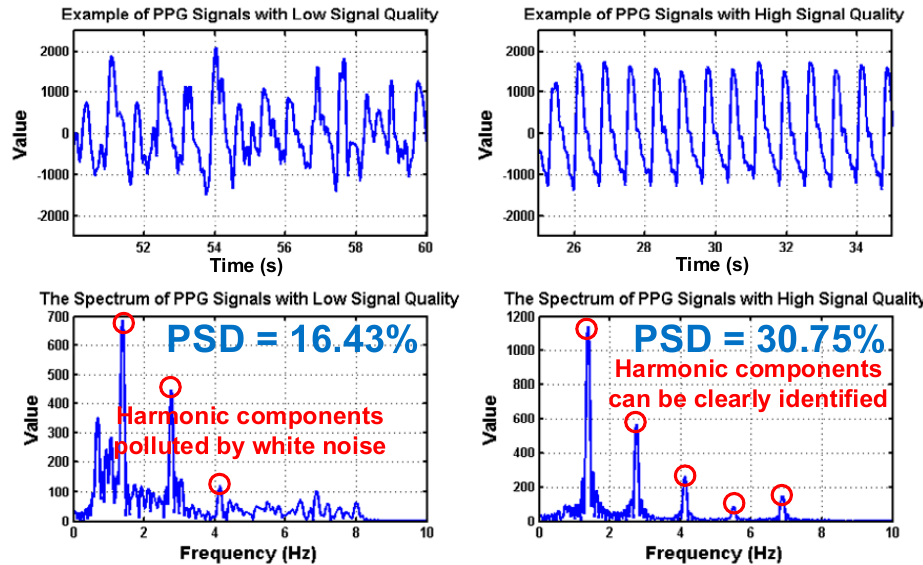
Figure 10. PPG signals with low and high signal quality following the corresponding spectrums, where the values of power spectrum density (PSD) are also shown.